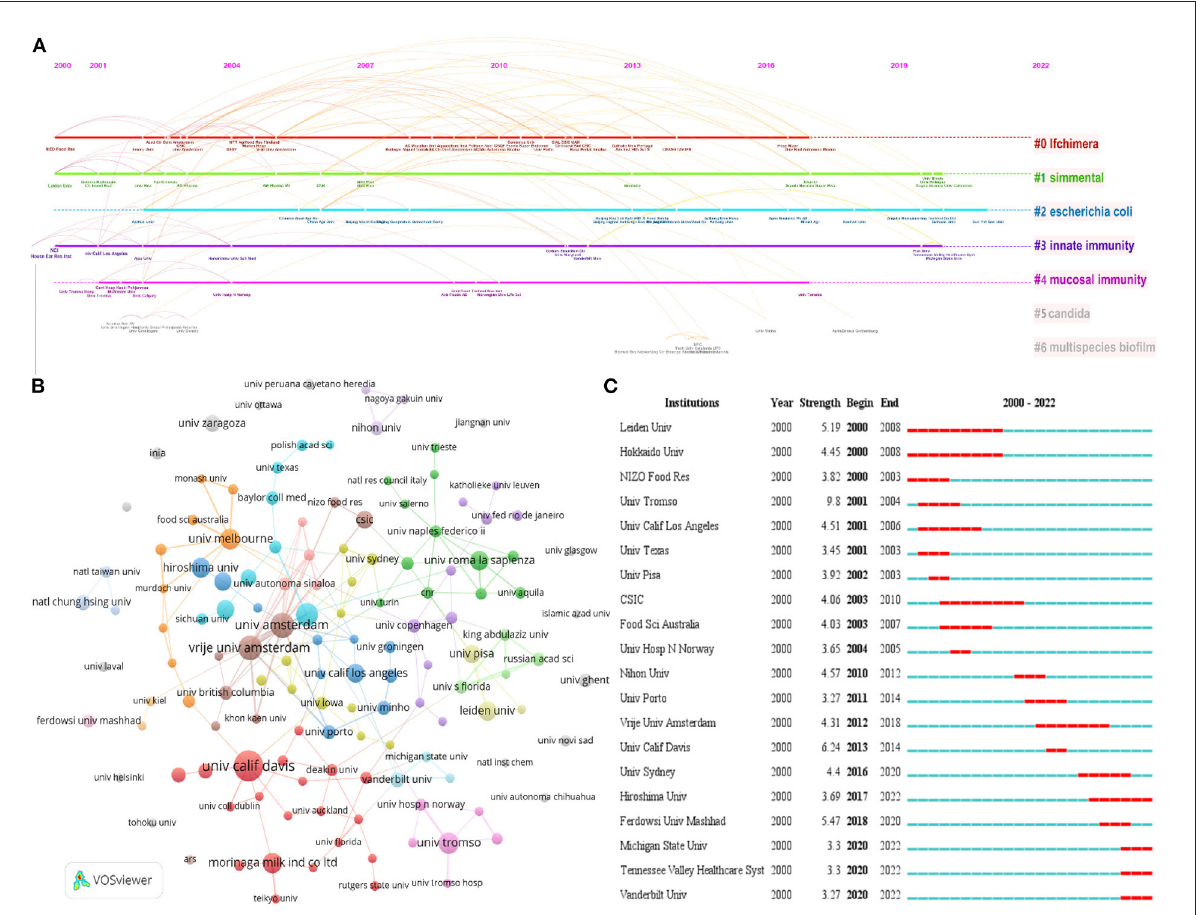
FIGURE3 (A) Timeline view of institutions coauthorship cluster analysis in LF antibacterial research. (B) Institutions’ coauthorship network visualization map. (C) Top 20 institutions’ coauthorship with strong occurrence